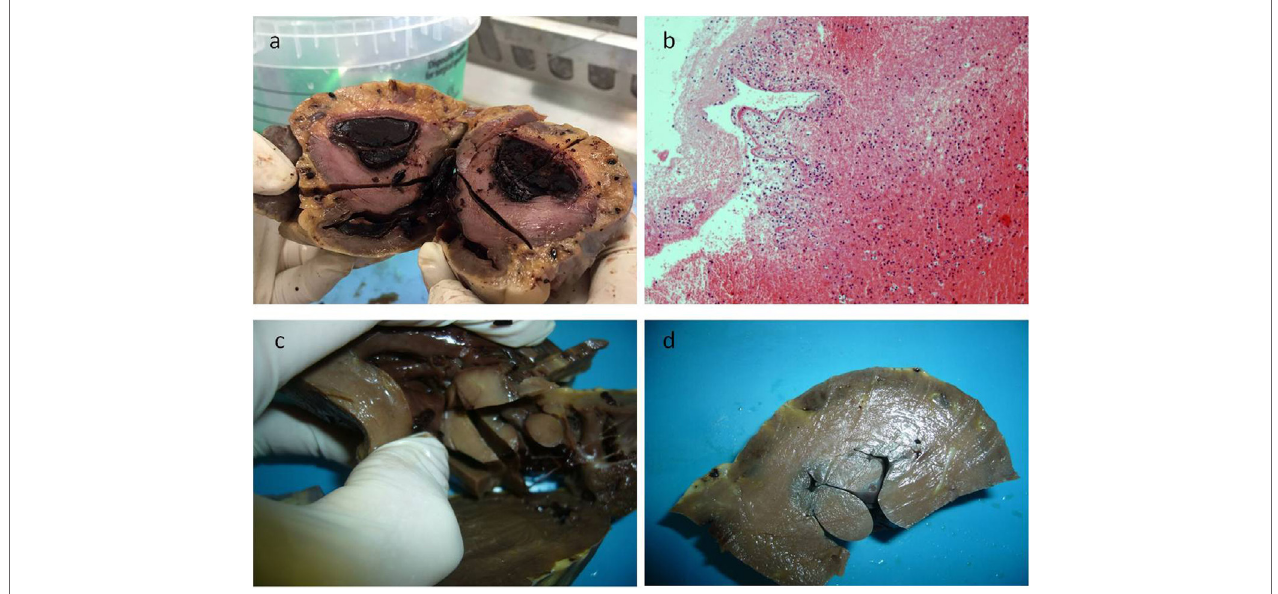
FIgURe 1 | In panel (a) , the gross appearance of the lesion, and in panel (B) the microscopic of the blood clot that was first found during dissecting the heart, consisting in fibrin and poor in cells. After removing the clot, a papillary multiple lesion was found, the base of which was in the wall of the ventricle (C,D) . FIgURe 2 | (a) The ventricle hypertrophy (E/E 63 × ). (B–D) The papillary ventricular lesion consisted mainly in connective tissue, poor in cells [E/E 20 × in (B) , 10 × in (C,D) ]. (e) Collagen and elastic fibers (special stain. Sirius Red 10 × ). (F) The surface was positive for anti-FVIII (40 × ); and a diffuse, sparse positivity for anti-CD34 [20 × in (g) ] and anti-S-100 superficial and spars [20 × in (I) ] was found; few cells instead were positive for anti-Actin [40 × in (H) ].